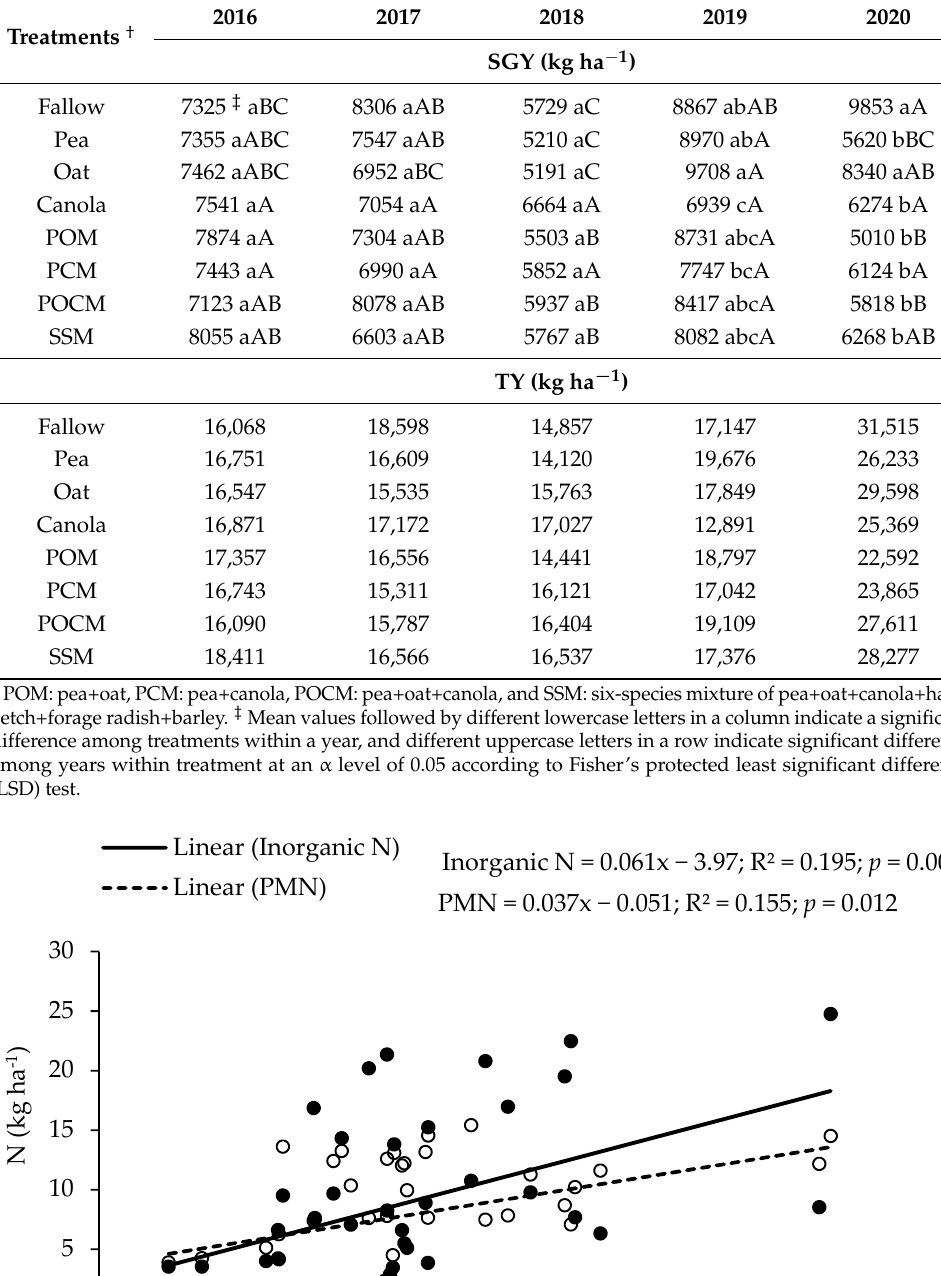
Table 4. Means of sorghum grain yield (SGY) and total yield (TY) during 2016–2020.